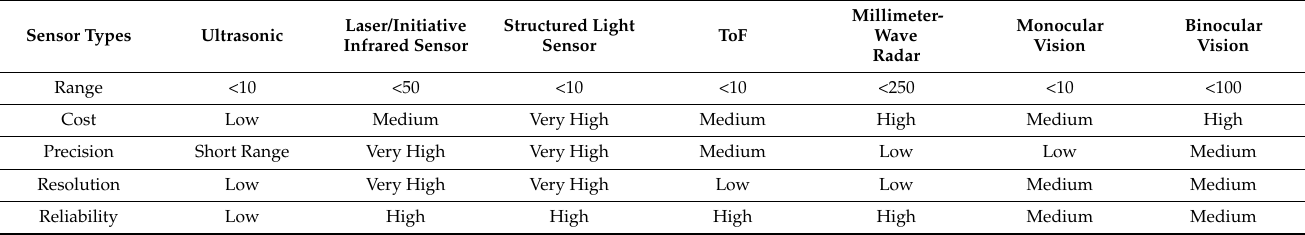
Table 2. Obstacle detection sensors for